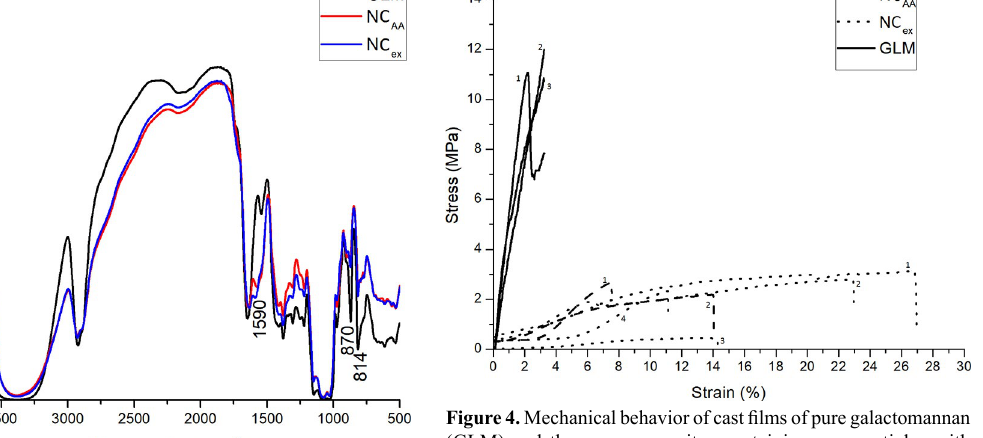
(▲), NC (▼) and CF (■) as a function of storage time when exposed to a) ex AA AA saturation at 25 ºC in absence of light. 2